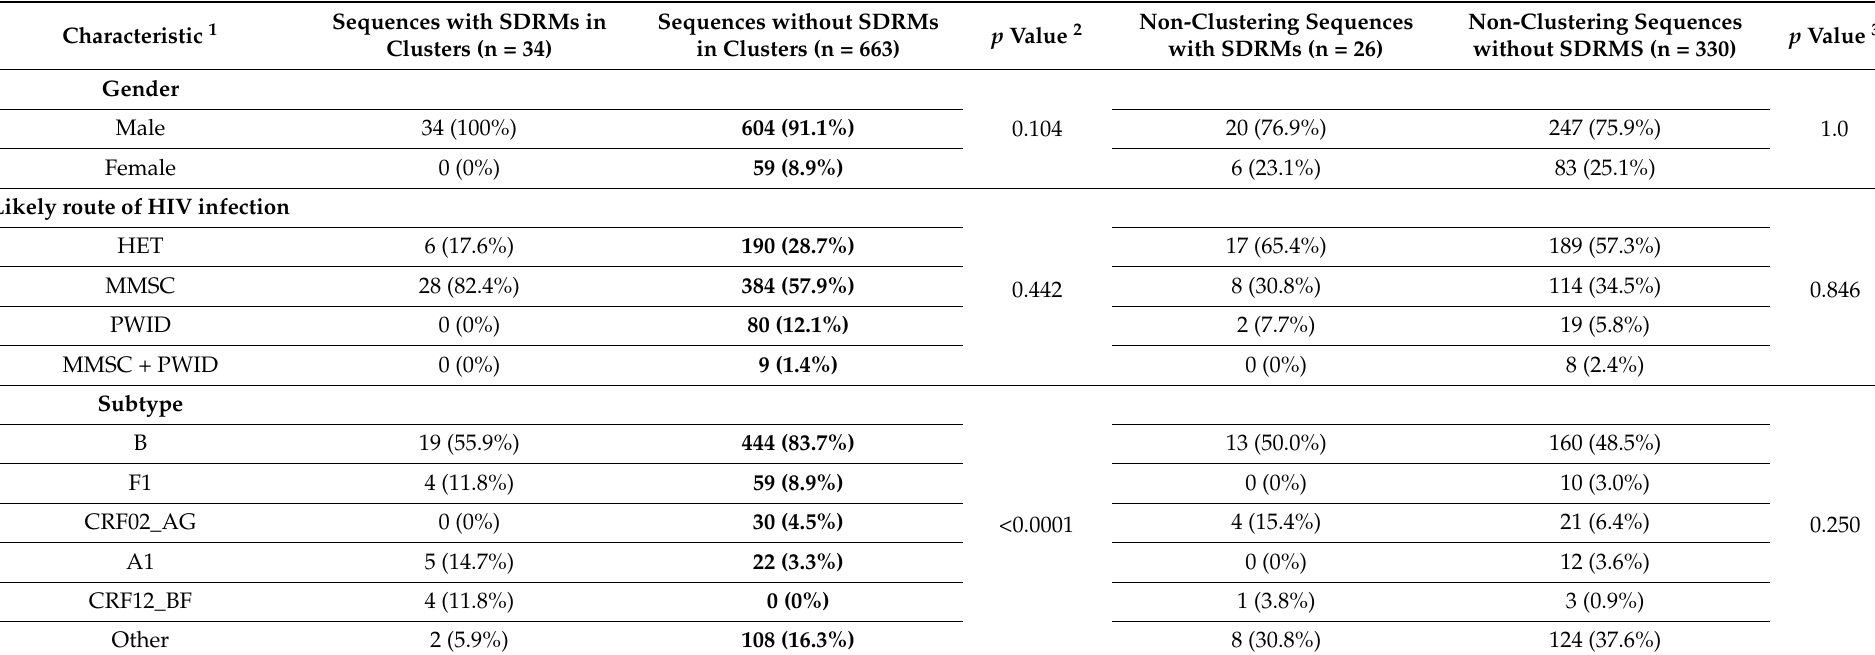
Table 3. Comparative characteristics of people with HIV-1 surveillance drug resistance mutations (SDRMs) with sequences in clusters versus those that do not